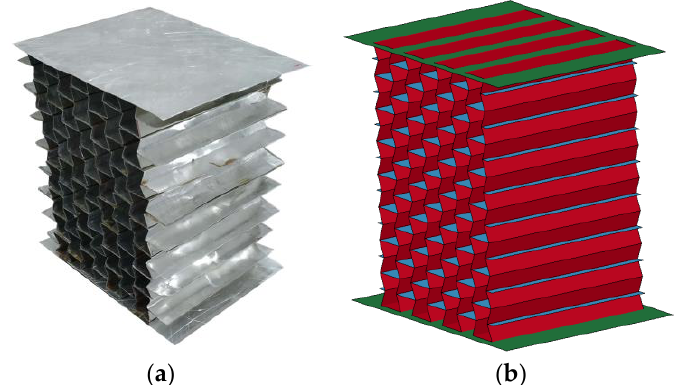
Figure 6. The hollow auxetic honeycomb: ( a ) photo; ( b ) numerical model.